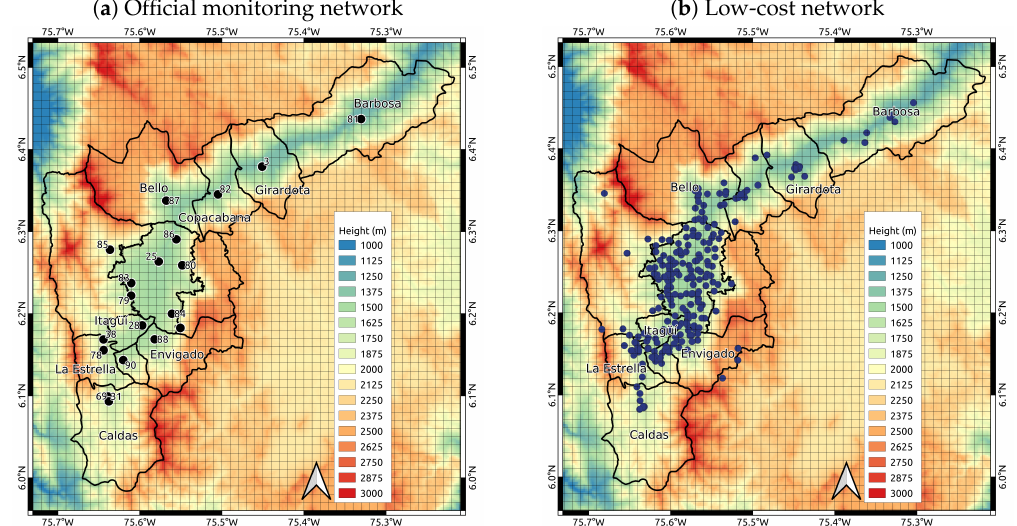
Figure 1. Spatial distribution of the hyper-dense low-cost network Citizen Scientist and official monitoring air-quality network for particulate matter (PM) 2.5 . The gray raster represent the Long Term Ozone Simulation-European Operational Smog (LOTOS-EUROS) model grid, the black lines are the boundaries of the municipalities borders, and the numbers are the official station numerations followed by